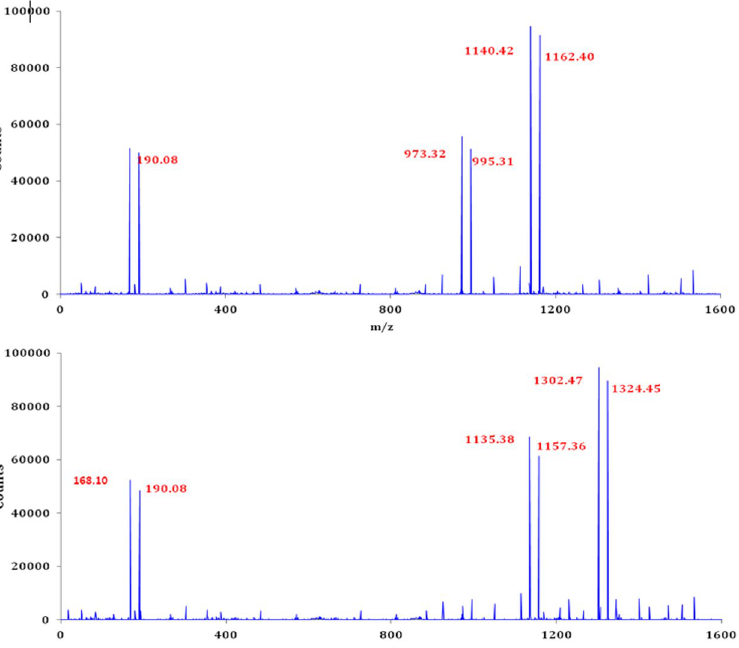
Figure 12. (a , b) HRMS spectra of the (a) SNP + α -CD, PEH + α -CD and (b) SNP + β -CD, PEH + β -CD